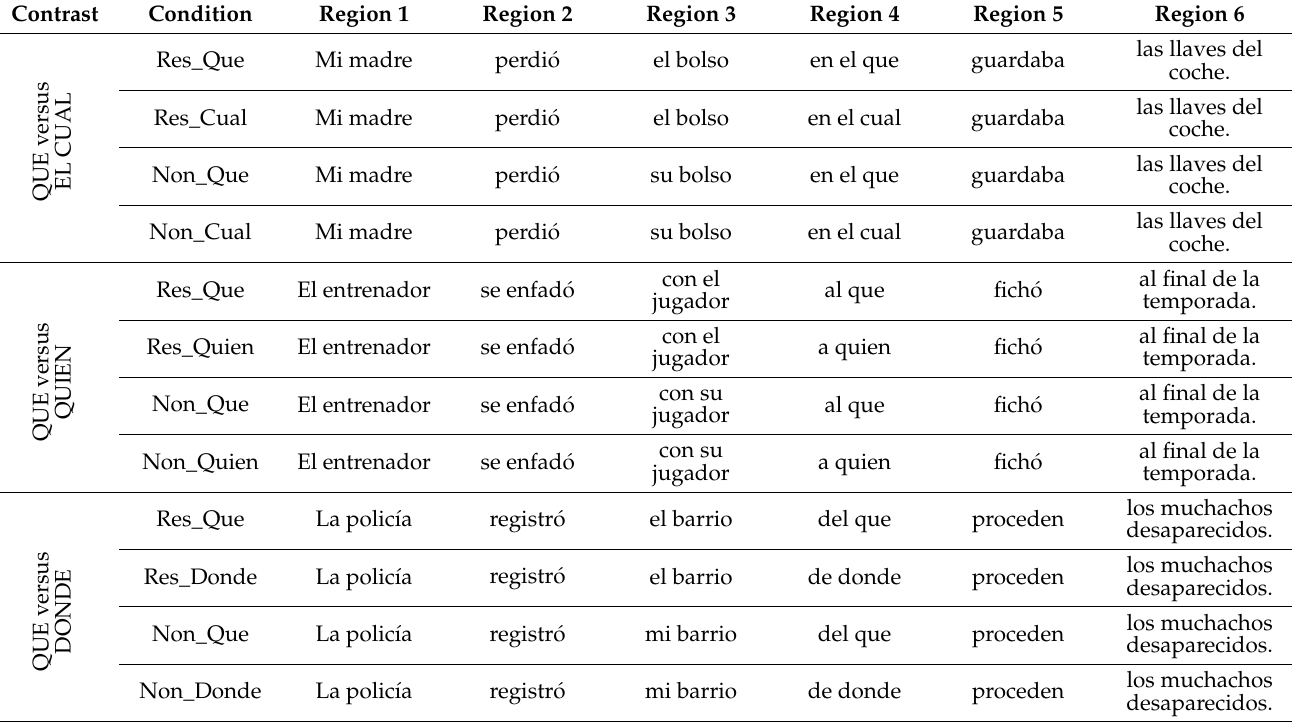
Table 4. Division of the experimental items into six regions according to the syntactic structure. “Res” refers to restrictive RCs and “Non” to non-restrictive